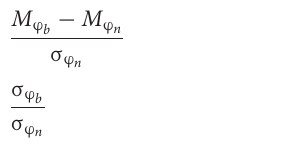
Frontiers in Marine Science |